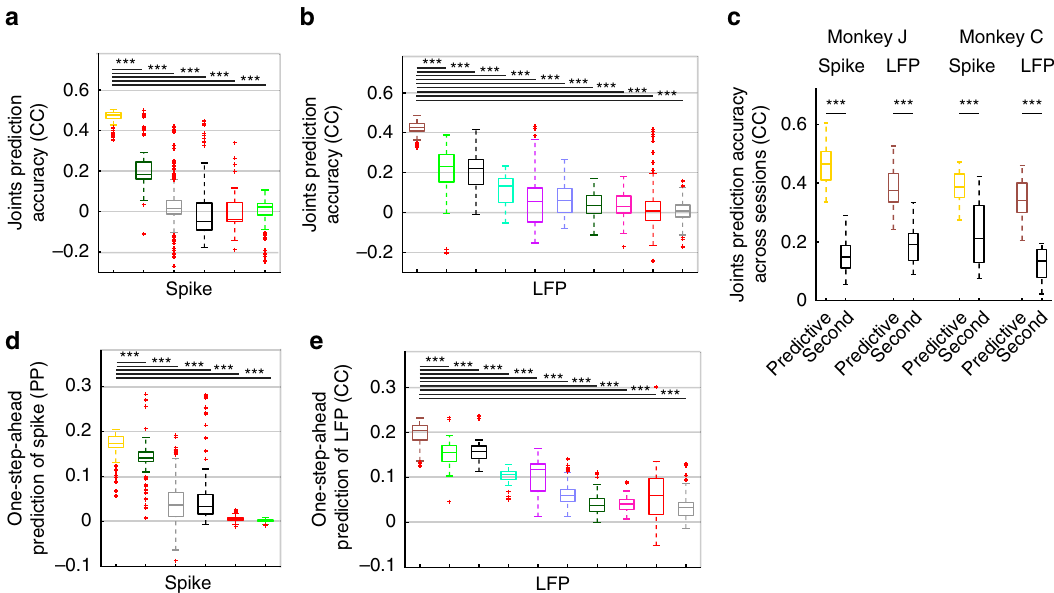
Fig. 4 In both spiking and LFP activity, one mode is dominantly predictive of behavior. a Joint angle prediction accuracy statistics are shown for the members of the mode clusters in spiking network activity in the sample session shown in Fig. 3. Colors represent the colored clusters in Fig. 3. The yellow cluster termed predictive mode has signi fi cantly higher prediction accuracy than every other cluster ( P < 8.1 × 10 − 28 , N s > 97 yellow cluster members, one- sided Wilcoxon rank sum test). The line inside boxes shows median, box edges represent the 25th and 75th percentiles, whiskers show the minimum and maximum values excluding outliers and red crosses indicate the outliers. Outliers are the points that are >1.5 times the box size away from the beginning and end of the box. b Similar to ( a ) for LFP network activity, where the brown cluster (predictive mode) has signi fi cantly higher prediction accuracy than every other cluster ( P < 1.4 × 10 − 4 , N s > 99 brown cluster members, one-sided Wilcoxon rank sum test). c In each monkey, among all principal modes in spiking activity, the prediction accuracy of one of them (termed predictive mode) is signi fi cantly better than that of the second best principal mode shown by black box plots (yellow vs. black). The same result holds for LFP activity, and its predictive mode and second best principal mode (brown vs. black). Signi fi cance is shown by asterisks ( P < 1.8 × 10 − 20 , N s = 35 and 20 cross-validation folds for Monkeys J and C, one-sided Wilcoxon signed-rank test). d Boxplot of the prediction power (PP) of mode clusters in predicting spiking activity. Higher prediction power indicates better one-step-ahead prediction of spiking activity. The same predictive mode that dominantly predicted behavior had the best one-step-ahead prediction of spiking activity (yellow mode cluster, P < 9.9 × 10 − 17 , N s > 97 cluster members, one-sided Wilcoxon rank sum test). e Similar to ( d ) but for the correlation coef fi cient (CC) of mode clusters in one-step-ahead prediction of LFP. The same predictive mode cluster that dominantly predicted behavior had the best one-step-ahead prediction of LFP activity (brown mode cluster, P < 3.5 × 10 − 11 , N s > 99 cluster members, one-sided Wilcoxon rank sum test). Source data are provided as a Source Data fi